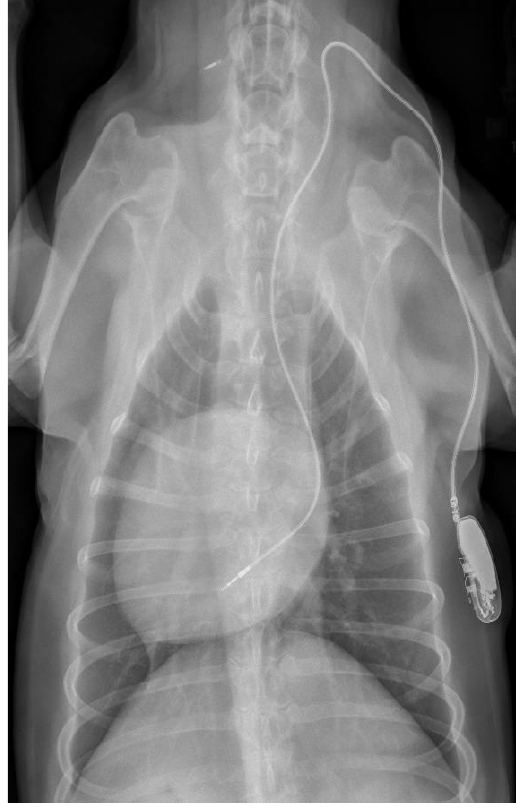
Figure 3. Postoperative thoracic radiographs, lateral and dorso-ventral positions, show appropriate placement of the pacing